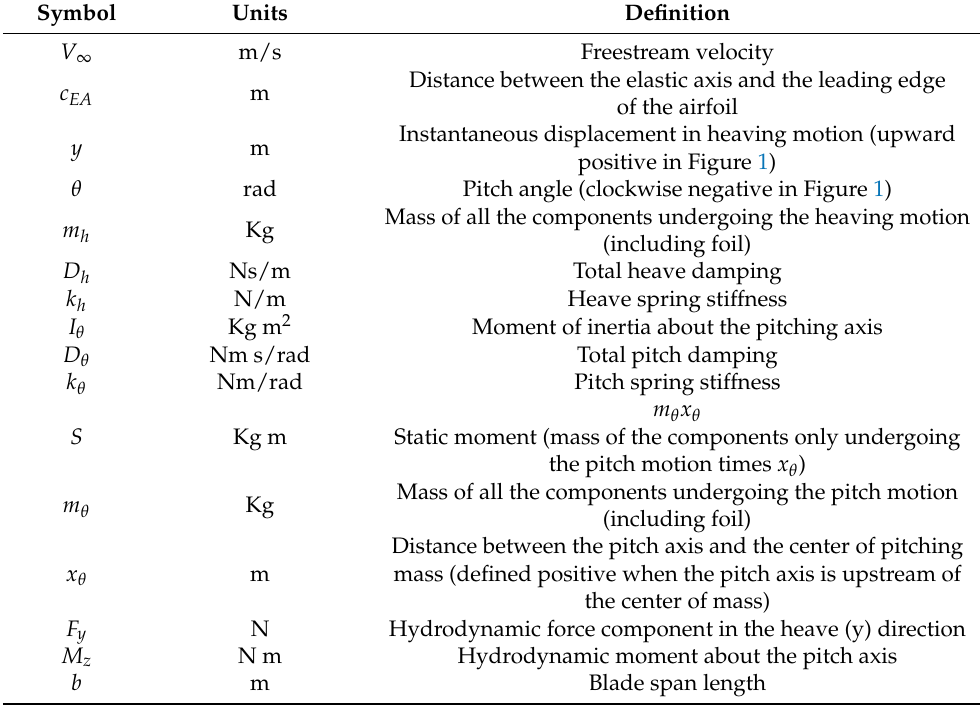
Table 1. List of the parameters involved in the equations of